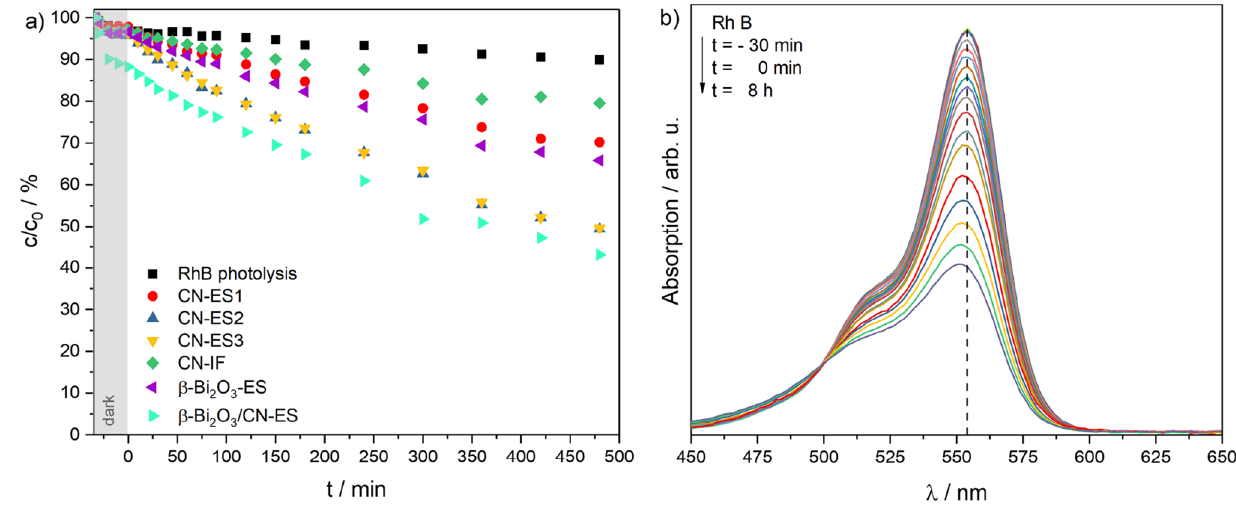
Fig. 5 a Time-dependent photodegradation of an aqueous RhB solution (1 × 10 −5 M) under visible light irradiation with a 300 W Xe-lamp (t > 0 min) without catalyst and in the presence of the